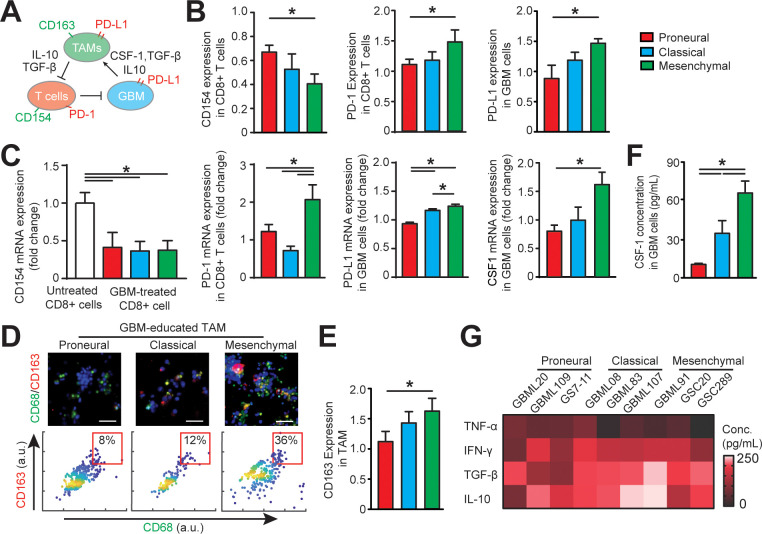
Distinct systemic immunosuppression in PN, CL and MES GBMs.(A) A schematic highlighting the systemic immunosuppressive signaling among GBM, TAM and CD8+ T-cell via CSF-1/CSF-1R, immunosuppressive cytokines and PD-1/PD-L1. (B) Quantified CD154 and PD-1 expressions (normalized to untreated) on allogeneic CD8+ T-cell, and PD-L1 expression (normalized to untreated) on GBM cells of PN (GBML20), CL (GBML08) and MES (GBML91) subtypes, showing higher expressions of PD-1 and PD-L1 in the MES GBM niche as compared to the PN and CL GBM niches. Surface marker expression was quantified by the mean intensity of each cell. (C) qPCR analysis showing different CD154 and PD-1 expressions in CD8+ T-cell, PD-L1 and CSF-1 expressions in GBM cell. (D) Representative immunofluorescence images showing more immunosuppressive M2-like macrophages in the MES GBM (GBML91) than the PN and CL subtypes. Scale bar is 50 µm. (E) Quantified M2-like marker CD163 expression (normalized to untreated group) on TAM, in different GBM subtypes, showing higher TAM CD163 expression in MES GBM compared to PN (GBML20) and CL (GBML08) GBMs. (F) ELISA results showing high CSF-1 level expressed by MES (GBML91) GBM. (G) Quantified cytokine levels in different GBM derived niches, showing relatively higher expressions of immunosuppressive cytokine (TGF-β1 and IL-10), lower expressions of pro-inflammatory cytokines (IFN-γ and TNF-α) in MES GBM (GBML91). Error bars represent ± s.e.m., n > 80 in B, D, and F. P-values were calculated using one-way ANOVA. *, p<0.05.